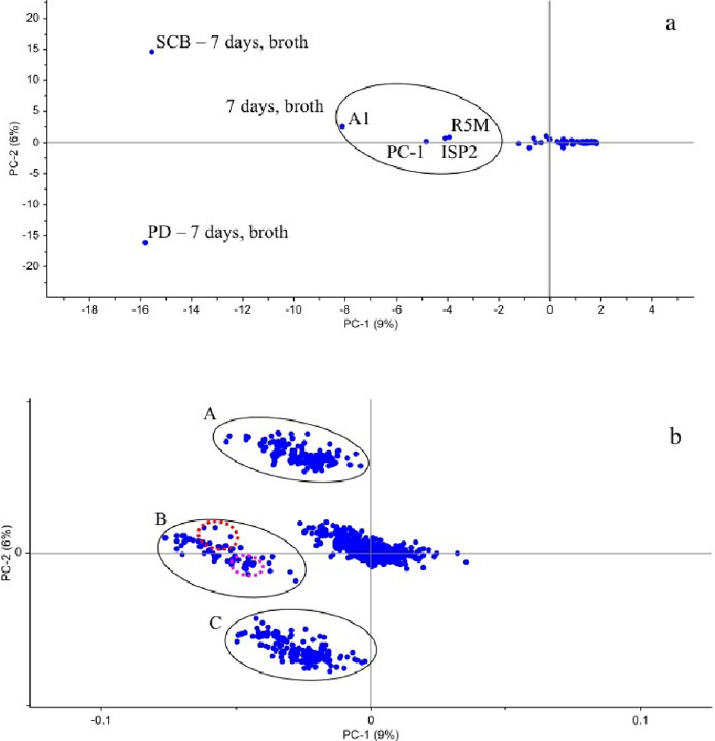
Fig 6. PCA evaluation of all extracts obtained from cultivation of Streptomyces sp. strain BRB081. a) Scores plot highlights samples with unique chemical composition. b) Loadings plot groups A, B and C combine the compounds responsible for the differences observed in Scores plot. The red region corresponds to surugamides analogues while the pink region comprises ions m/z 648.6, 678.7, 720.8, 734.7 and the other putatively new analogues from the cluster in Fig 2.